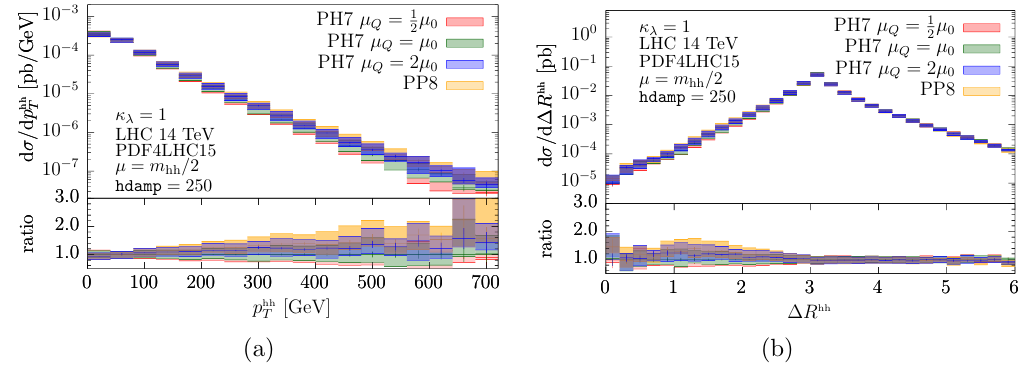
Figure 7. Higgs boson pair transverse momentum and R -separation for variations of the Herwig ~ q -shower hard